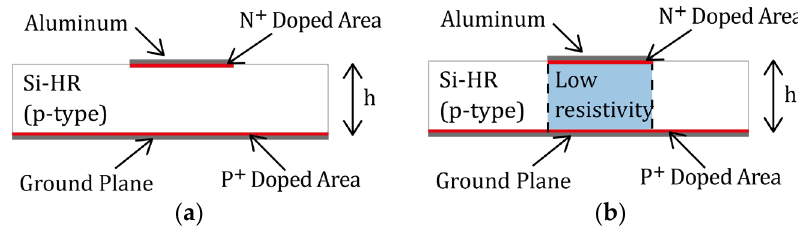
Figure 10. ( a ) OFF-state modeling. ( b ) ON-state modeling. The simulated results obtained using the electromagnetic software HFSS TM are pre- sented in Figure 11 in both states.